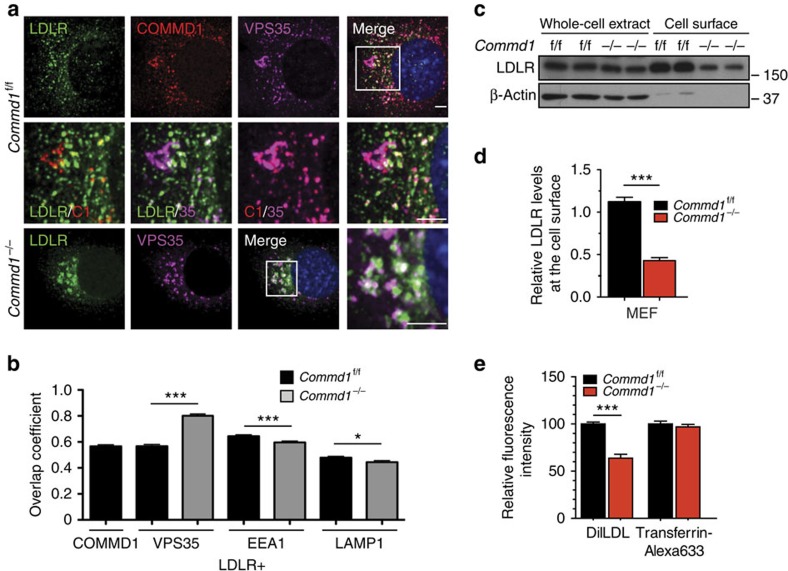
COMMD1 deficiency impairs the function of LDLR.(a) LDLR (green), COMMD1 (red) and VPS35 (pink) were stained in Commd1f/f and Commd1−/− MEFs and imaged by confocal microscopy. Representative images are shown; scale bar, 5μm. (b) Quantification of the colocalization of LDLR with COMMD1, VPS35, EEA1 and LAMP1 was performed by the analysis of 30–40 cells. (c) Total and plasma membrane LDLR levels of Commd1f/f and Commd1−/− MEFs determined by biotinylation assay. Data represent three independent experiments, and (d) the relative levels of LDLR at the cell surface are quantified in all experiments. (e) In vitro LDL and transferrin uptake assay. Dil-labelled LDL (5 μg ml−1) or Alexa-633-labelled transferrin (5 μg ml−1) was added to serum-depleted medium and incubated with MEFs at 4 °C for 1 h and subsequently at 37 °C for 5 min. Dil-labelled LDL and Alexa-633-labelled transferrin uptake was measured by FACS analysis, and the relative uptake in triplicate is shown. The results are presented as mean±s.e.m.; significance was calculated relative to the control group by unpaired Student's t-test; *P<0.05, ***P<0.001.